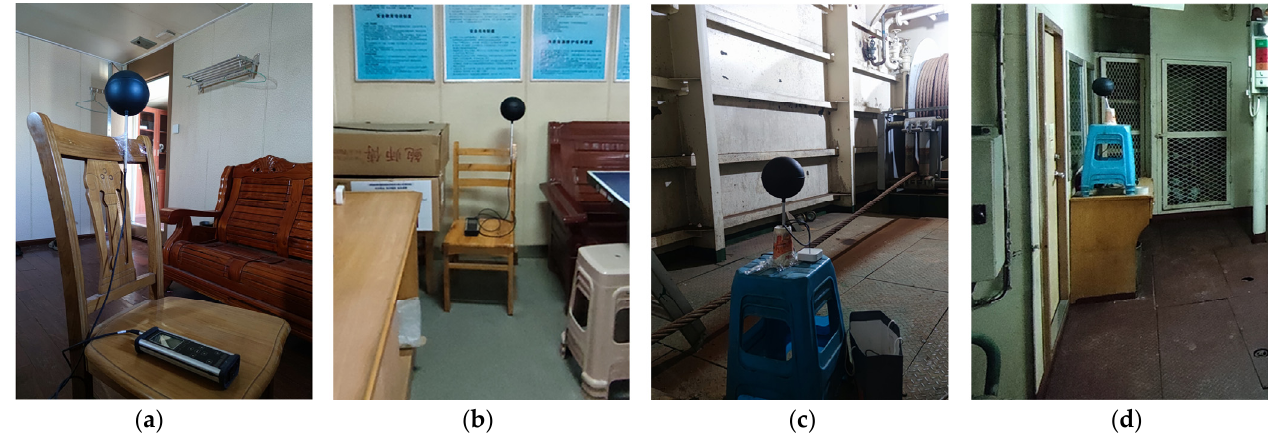
Figure 5. Data collection scenario in the ship. ( a ) Top living cabin, ( b ) meeting cabin, ( c ) stern winch cabin, ( d ) engine cabin.